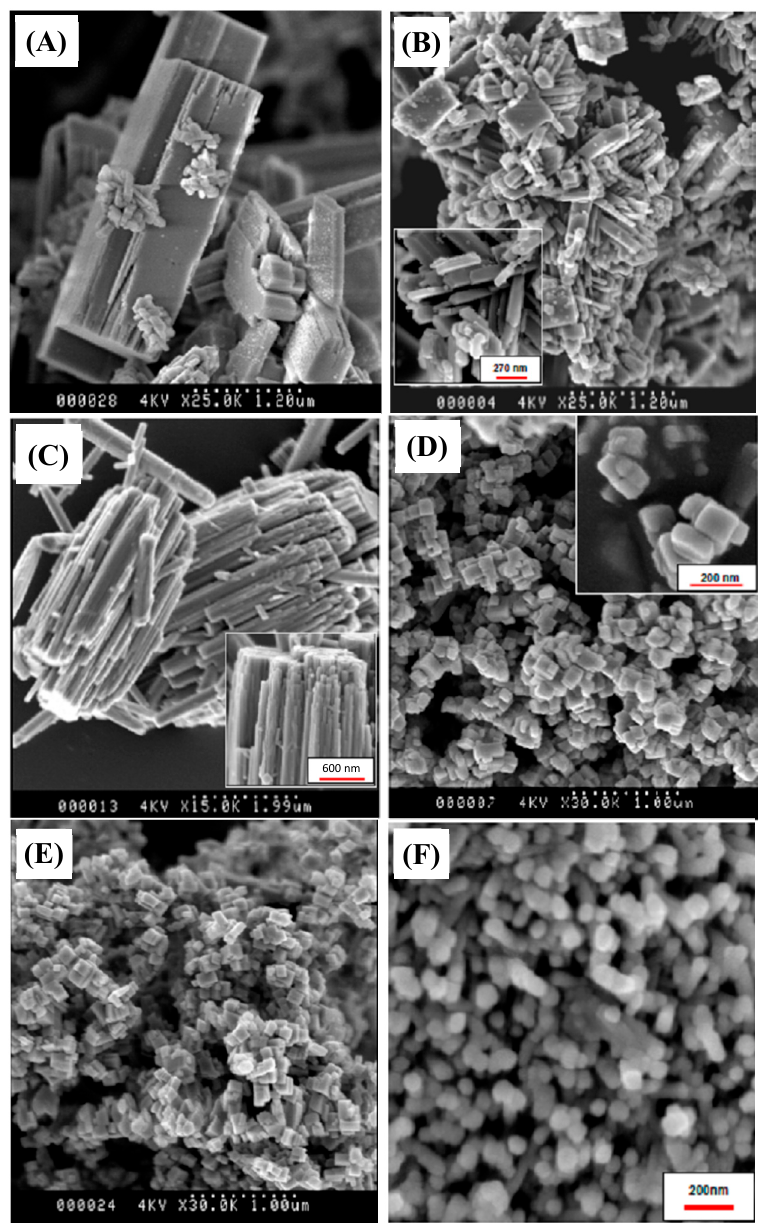
Figure 1. SEM images of: ( A ) hydrothermally synthesised WO 3 with no additives (W0); ( B ) hydrothermally synthesised WO 3 with Na 2 SO 4 added at a SO 42 − :WO 42 − ratio of 0.3 (W0.3NaS); ( C ) hydrothermally synthesised WO 3 with Na 2 SO 4 added at a SO 42 − :WO 42 − ratio of 7.6 (W7.6NaS); ( D ) hydrothermally synthesised WO 3 with H 2 SO 4 added at a SO 42 − :WO 42 − ratio of 0.3 (W0.3HS); ( E ) hydrothermally synthesised WO 3 with H 2 SO 4 added at a SO 42 − :WO 42 − ratio of 7.6 (W7.6HS); ( F ) commercial Sigma Aldrich WO 3